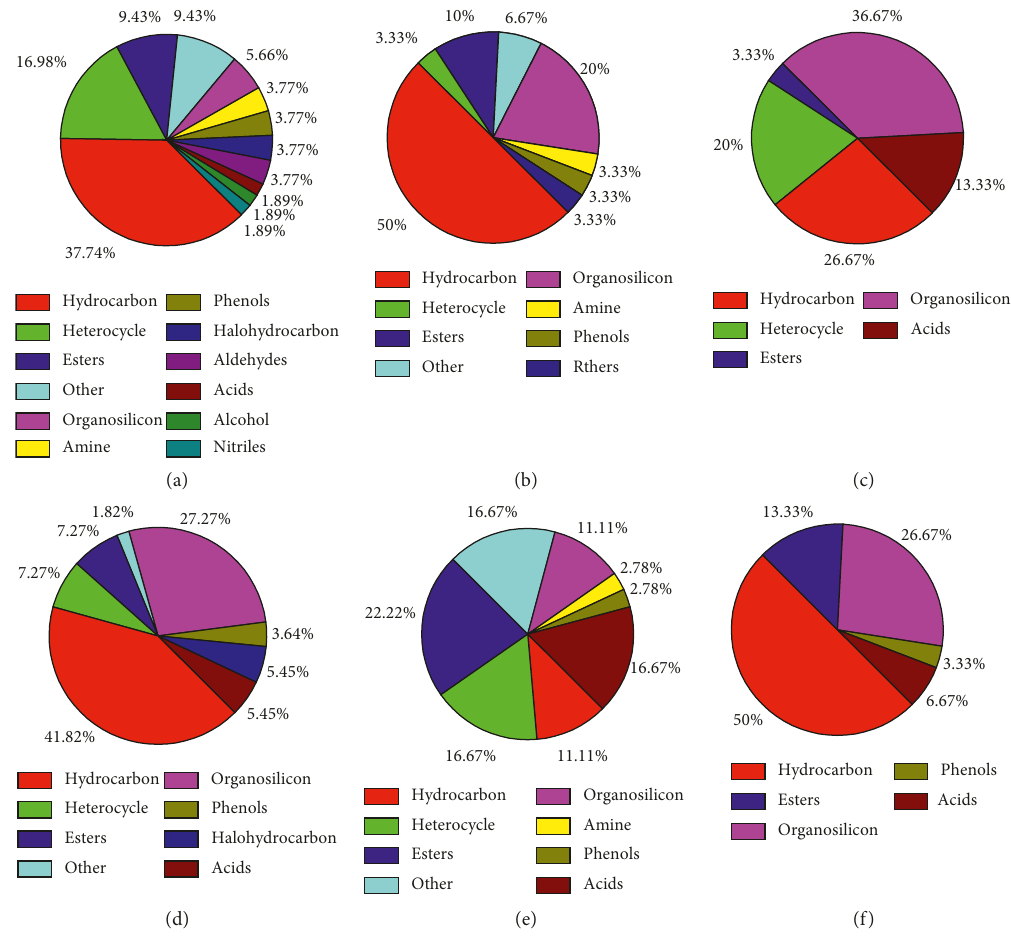
Figure 2: Distributions of the classes of refractory organic compounds in the influent and effluent from three types of typical pharmaceutical wastewater treatment plants: (a), (c), and (e) represent the influent of antibiotic wastewater, Chinese traditional medicine wastewater, and chemical synthesis wastewater, respectively; (b), (d), and (f) represent the corresponding